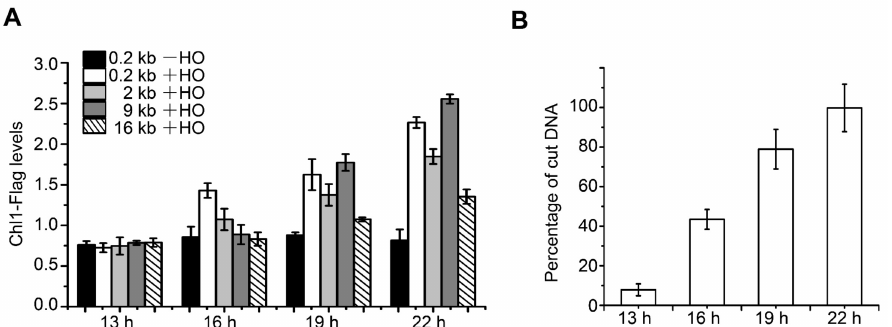
Figure 1. Chl1 is located at DSB sites. ( A ) ChIP assays were performed on the indicated strains before ( − HO) and after (+HO) 13, 16, 19, and 22 h of HO endonuclease induction. The quantitative PCR (qPCR) results displayed Chl1 levels at the 0.2, 2, 9, and 16 kb sites from the HO cleavage sites at the indicated induction time. ( B ) ChIP–qPCR results displayed HO cut efficiency after 13, 16, 19, and 22 h of HO induction, qPCR primer used was located on both sides of the DSB. The HO cut efficiency was similar in the HO-induced strains used. Data are displayed as the mean ± SEM of three independent